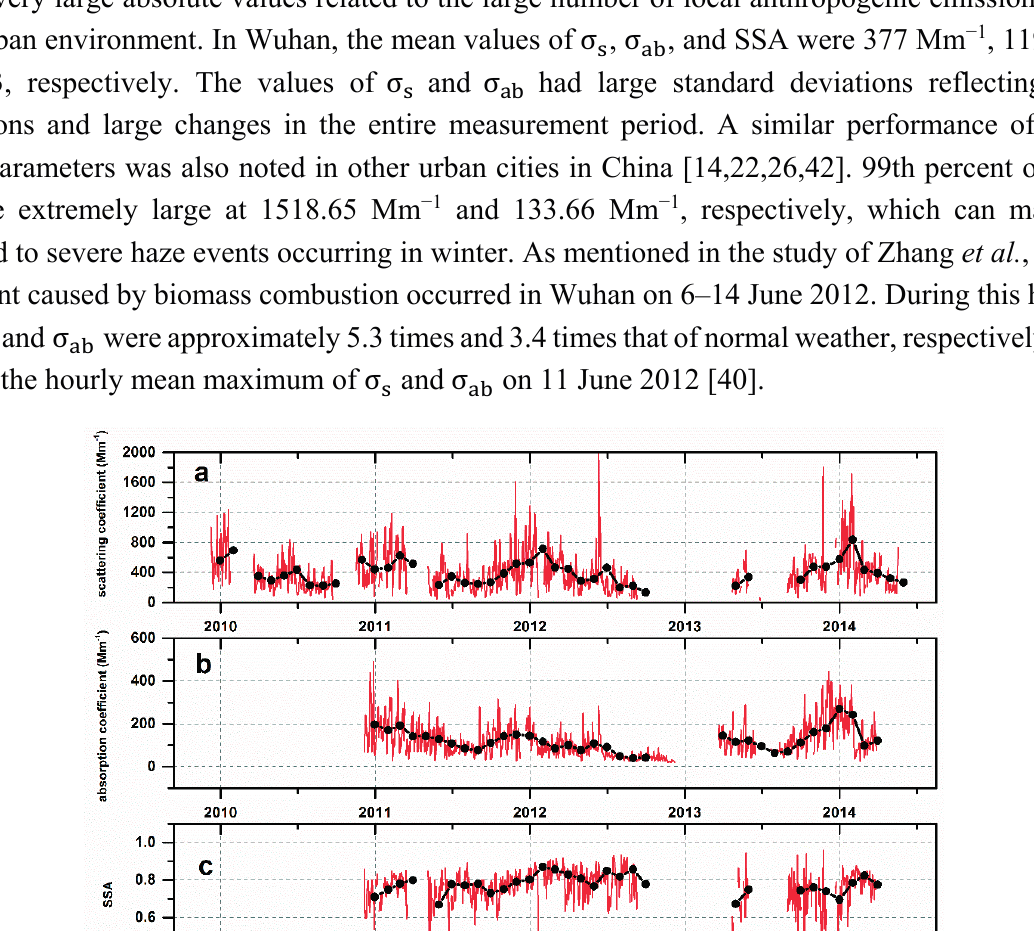
) and (cid:2911)(cid:2912)